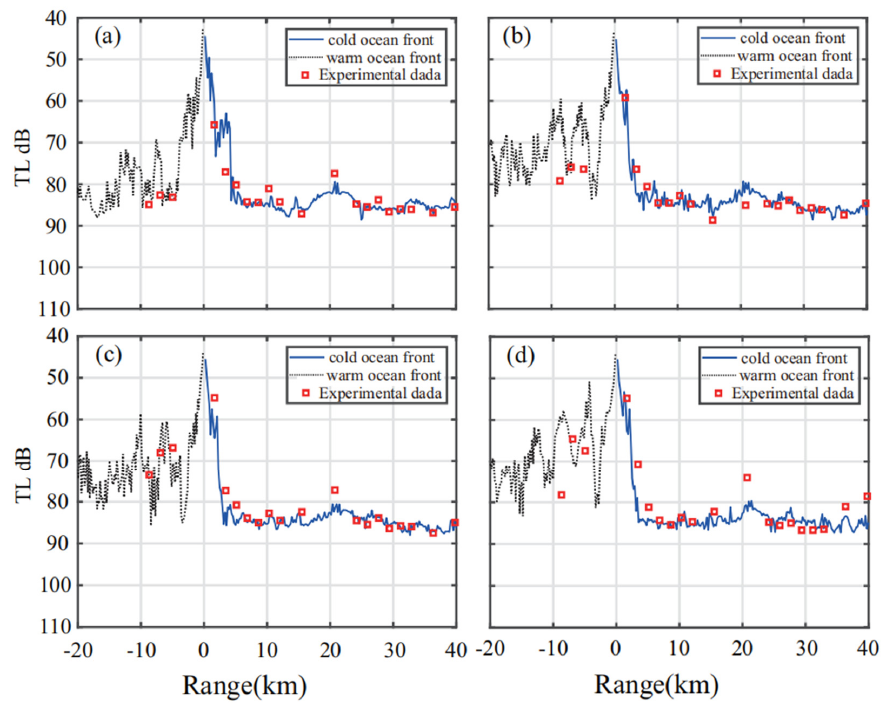
Figure 8. The TL in cold side (blue dotted line), warm side (black line), and experimental results with 100 m explosions (red square) in depths of: ( a ) 75 m; ( b )150 m; ( c ) 175 m; and ( d ) 200 m [11].